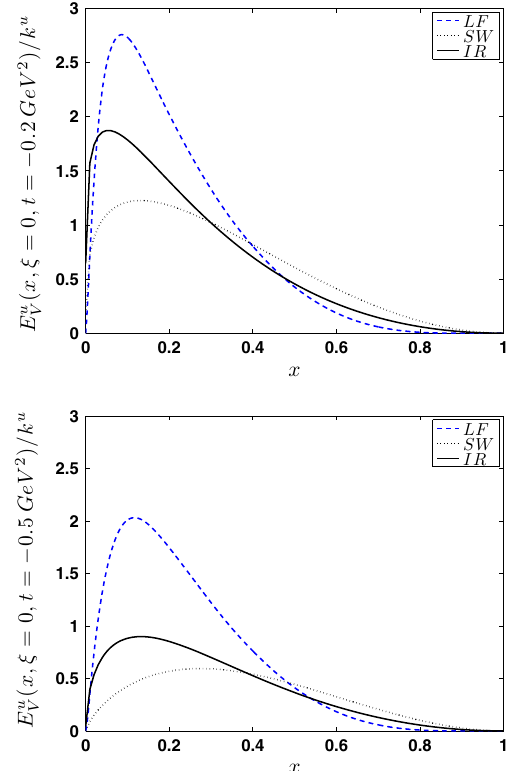
Fig. 5 Upper panel The results for H d ( x ,ξ = 0 , t = − 0 . 2GeV 2 ) predictedbytheimproved-IRmodelandtwist-3contributiononly( con- tinuous line ) are compared with the results obtained including higher Fock states ( dot-dashed ), namely ν = 3 , 4 , 5 (cf. Sect. 3.2). The predic- tions of the corresponding SW model are also shown ( dotted ). Lower panel As in the upper panel for t = − 0 . 5GeV 2